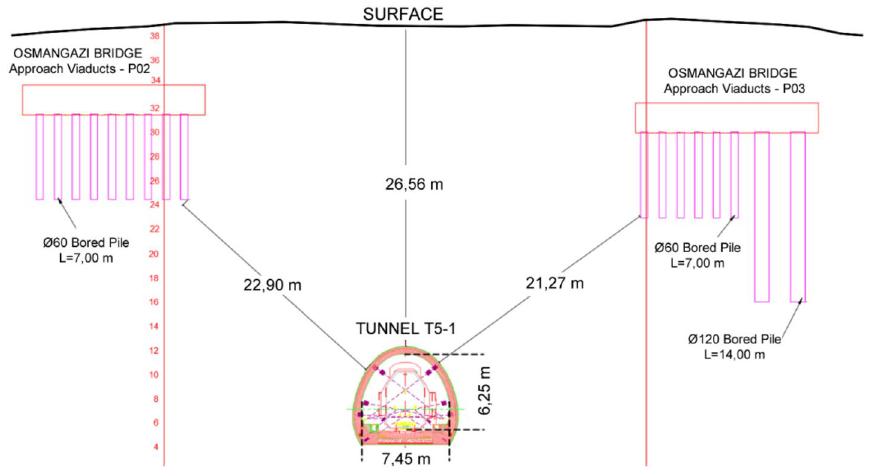
Fig. 2 Relationship between T5-1 Tunnel and Osmangazi Bridge north approach